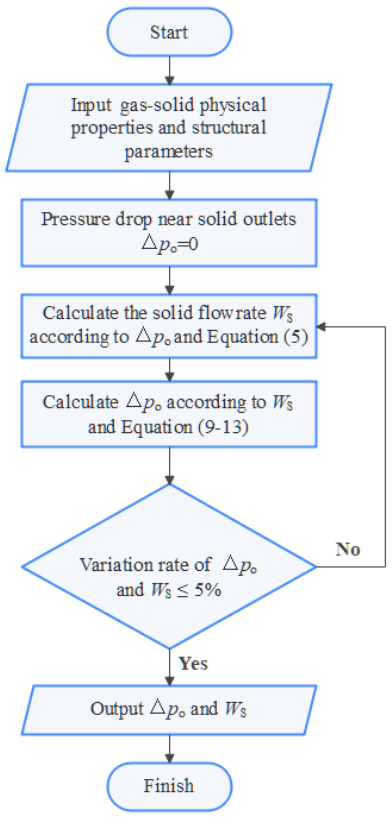
Figure 13. Illustration of iterative algorithm. In practical applications, the gas residence time t g ≈ Ah ε / Q g is a function of the gas flow rate, particle height, particle properties and bed structure. The solid residence time t s ≈ A ρ − ε )/ W s h (1 s is a function of the solid flow rate, particle height, particle